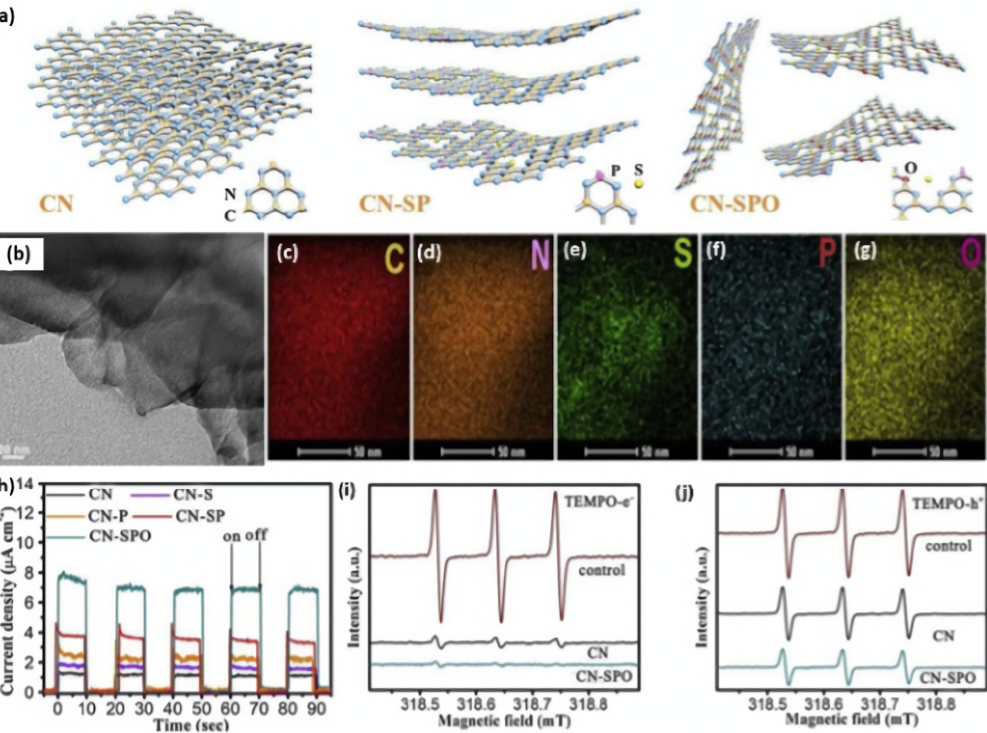
Figure 12. ( a ) Schematic illustration of exfoliation process of CN, CNSP, and CN-SPO. ( b ) TEM image and ( c – g ) EDX mapping of CN-SPO. ( h ) Transient photocurrent responses of CN-SPO and its counterparts. ( i ) ESR of electron and ( j ) hole of CN-SPO and CN. Adapted with permission from Ref. [161]. 2019, Elsevier Inc. N-, P-, and O-co-doped carbon (NPOC)-filled CN microtubes (NPOC@CN) were syn-